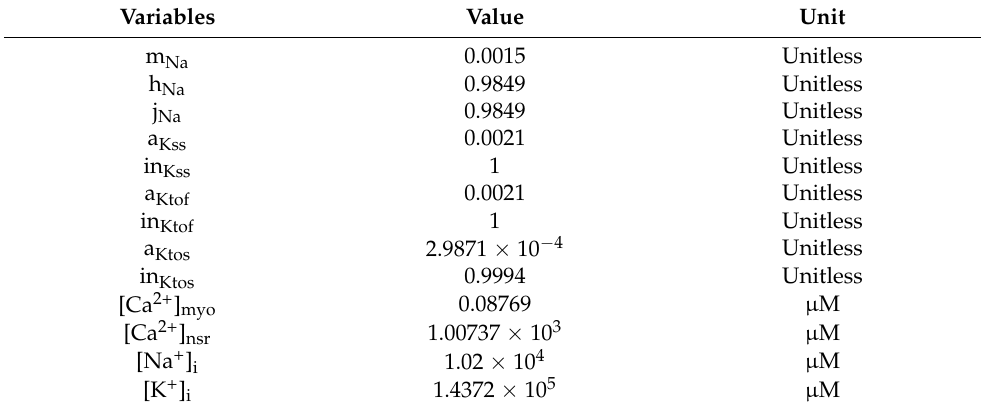
Table A2. Initial values.